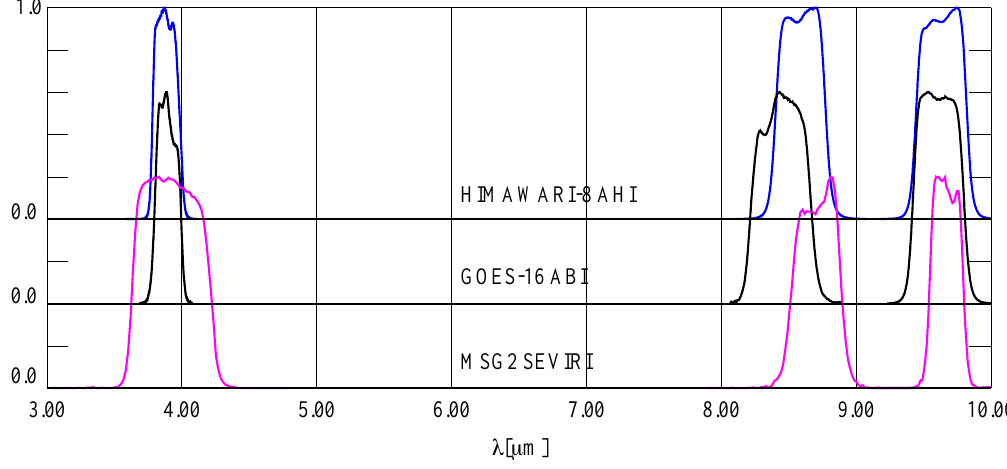
Figure 3. Normalized spectral response functions of Himawari-8 AHI, GOES-16 ABI, and MSG2 SEVIRI infrared bands in µm, shifted along the y -axis for the sake of clarity. These bands are used to build the Pseudo-Night Composites. Table 1. Parameters for the linear-log and linear transformations to the Pseudo Night Composites